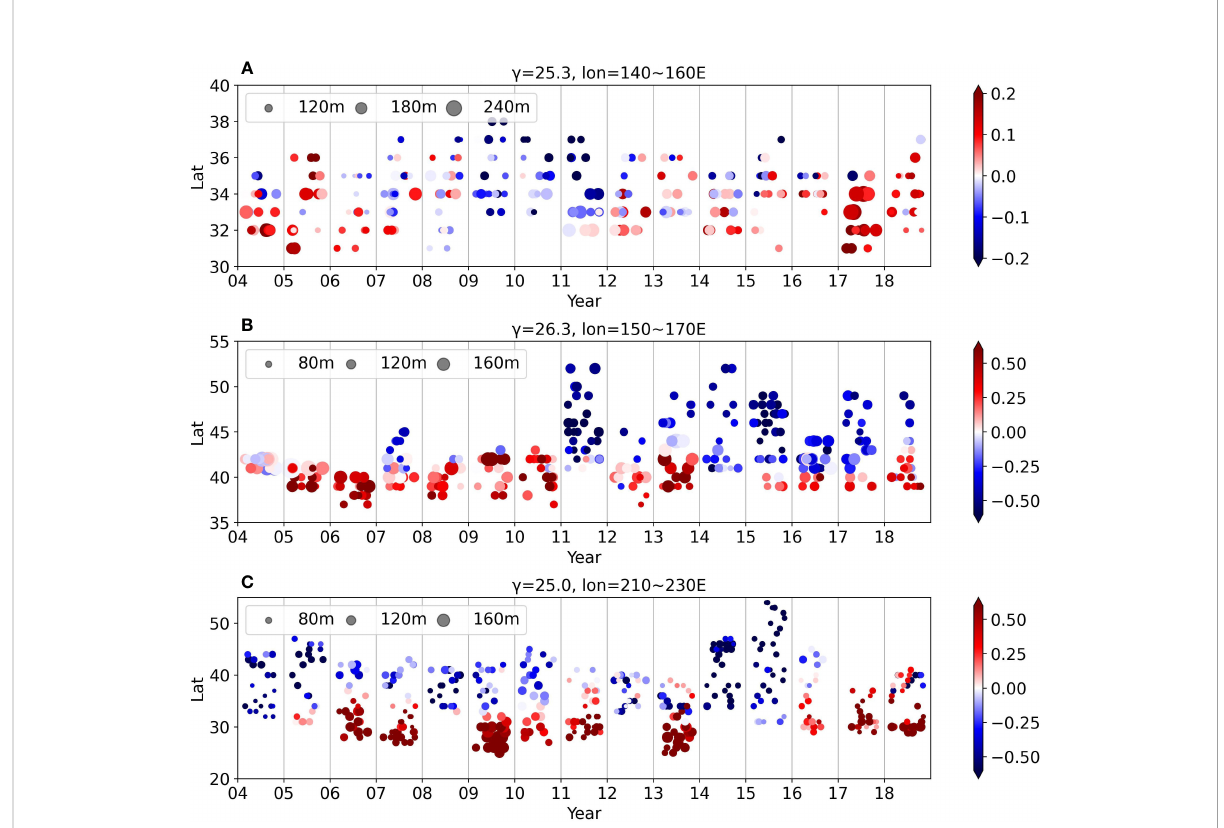
FIGURE 14 Scatter plots for the latitudes of the grids on late winter outcrop line of the mode water core surfaces in their main formation regions. (A) g = 25.3 in 140 – 160°E, (B) g = 26.3 in 150 – 170°E, and (C) g = 25.0 in 130 – 150°W. Colors in the scatters indicate salinity anomalies in late winter mixed layer, which were calculated by the salinity at a plotted grid subtracted by the climatological salinity that was averaged at the appropriate longitude on the outcrop line. Sizes of the scatters indicate late winter MLD. The horizontal positions of the scatters are distributed randomly within the bin of each year to avoid